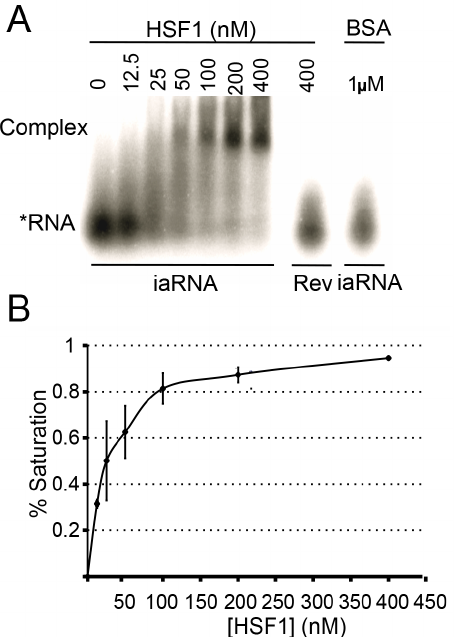
Figure 1. Specific binding of the aptamer to human HSF1 in vitro . ( A ) Electrophoretic motility shift assay (EMSA) using radiolabeled iaRNA HSF1 (1 nM) and increasing amounts of human HSF1 protein shows that the aptamer binds to its target avidly. ( B ) Quantification of independent EMSA reveals the apparent affinity of the iaRNA HSF1 for HSF1 as Kd , 25 nM (n=5).